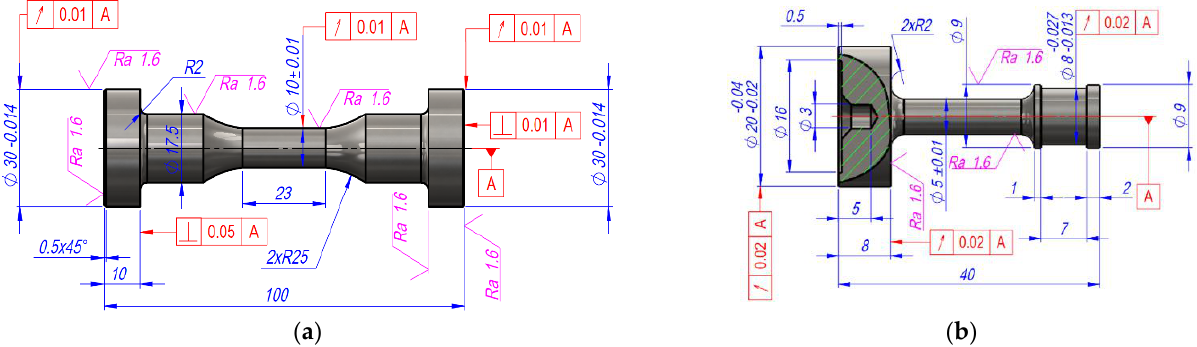
Figure 1. Shape and dimensions of the specimens for: ( a ) low-cycle fatigue tension-compression experiments; ( b ) monotonous tensile experiments.